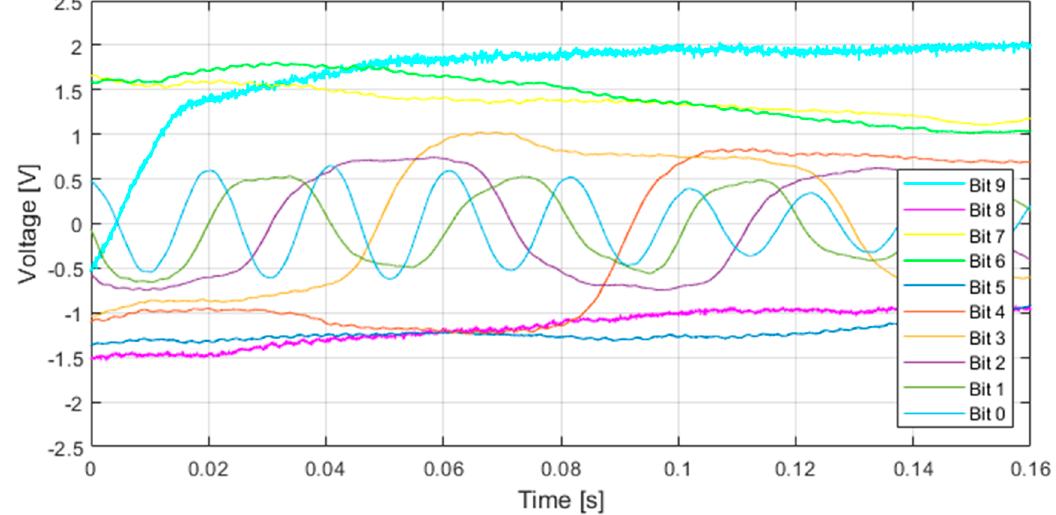
Figure 21. Signals of the Gray code encoder for all bits over a small angular range.